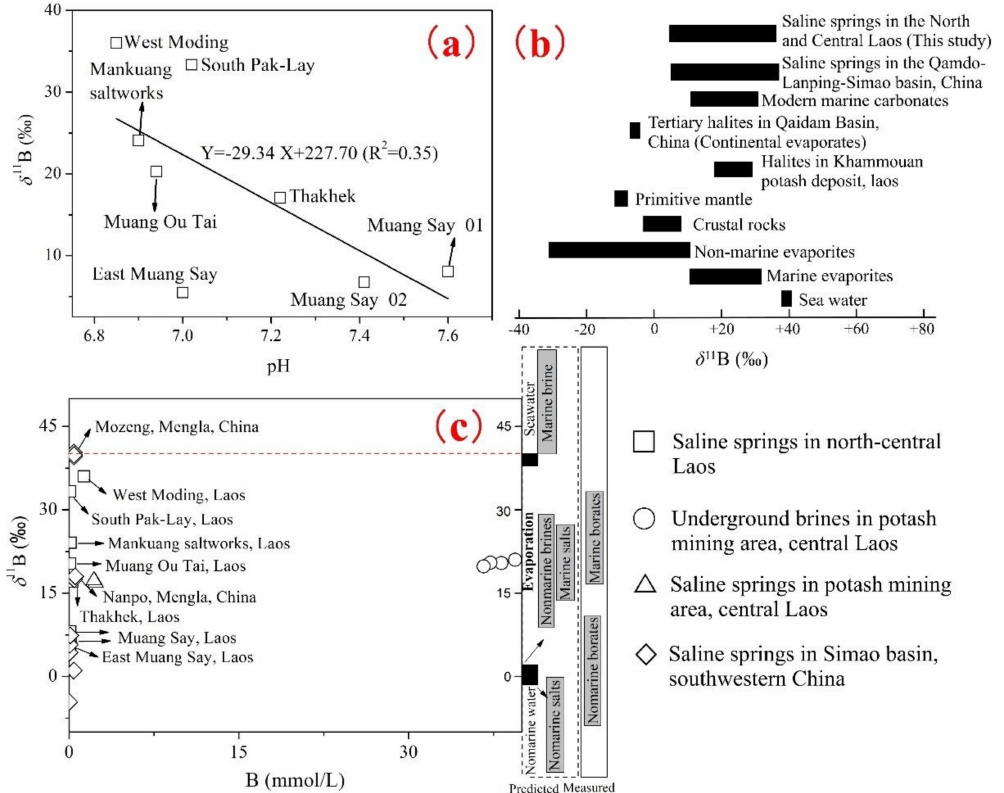
Figure 8. ( a ). pH vs. δ 11 B of saline springs from north and central Laos; ( b ). Range of δ 11 B values from different boron sources [7,79,106,111]; ( c ). δ 11 B vs. B of saline springs and underground brines from the southwestern China and north and central Laos compared with the predicted δ 11 B values based on experimental and measured δ 11 B values in natural systems of marine salts, marine brines, nonmarine salts, and nonmarine brines